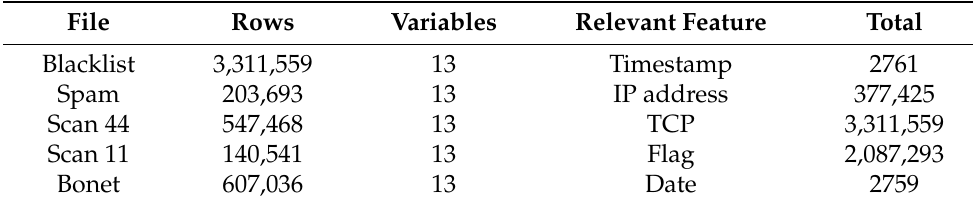
Table 5. The PCA results.